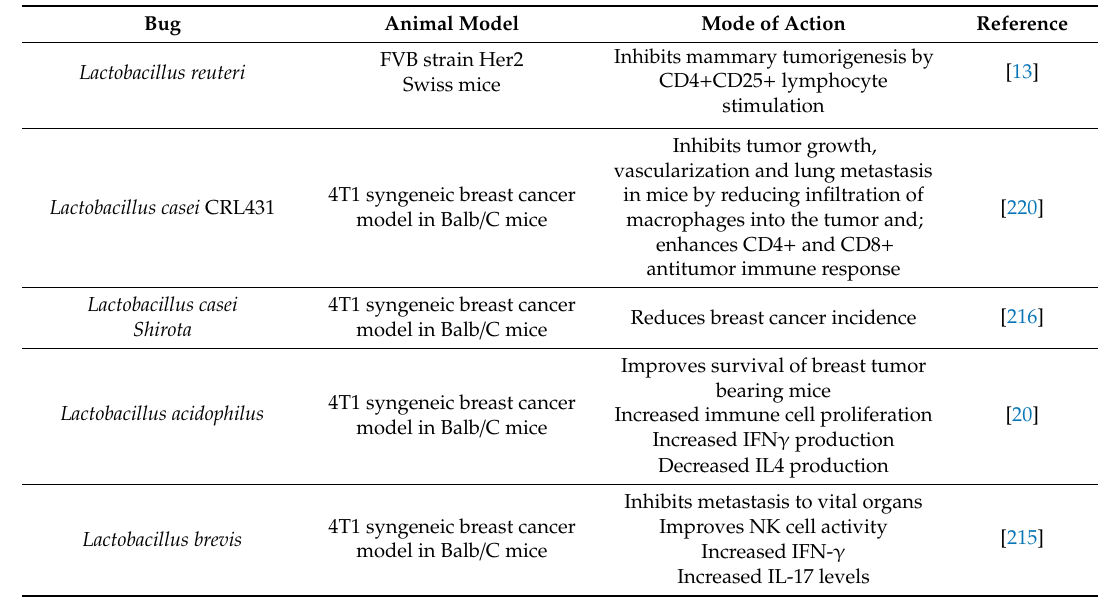
Table 2. Bugs as